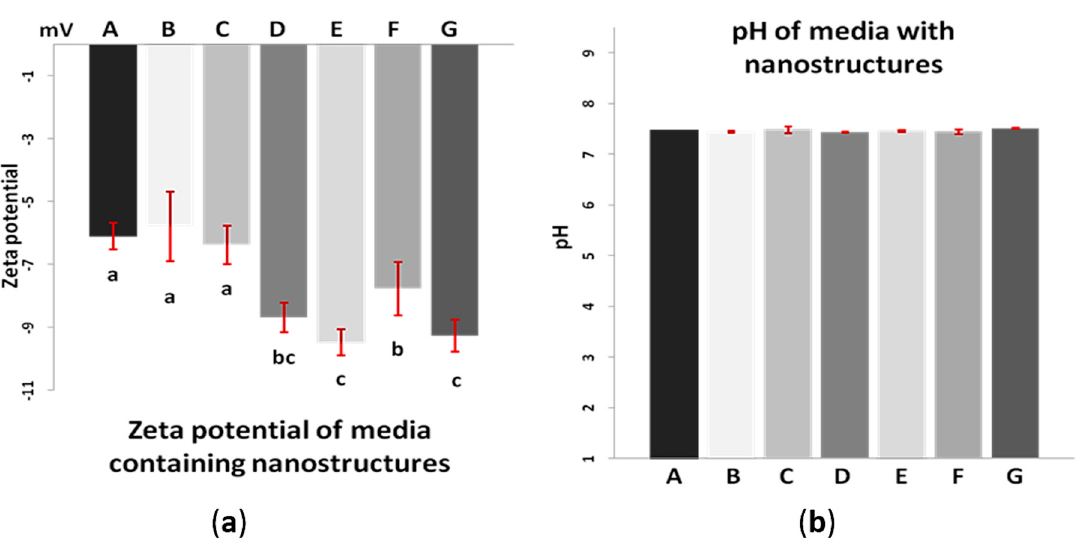
Figure 2. ( a ) Zeta potential of individual media with nanostructures. ( b ) pH values of individual media with nanostructures. (A) control medium; (B) medium with 2 μ g/mL AgNP; (C) medium with 10 μ g/mL AgNP; (D) medium with 0.4 μ g/mL HNC; (E) medium with 2 μ g/mL HNC; (F)